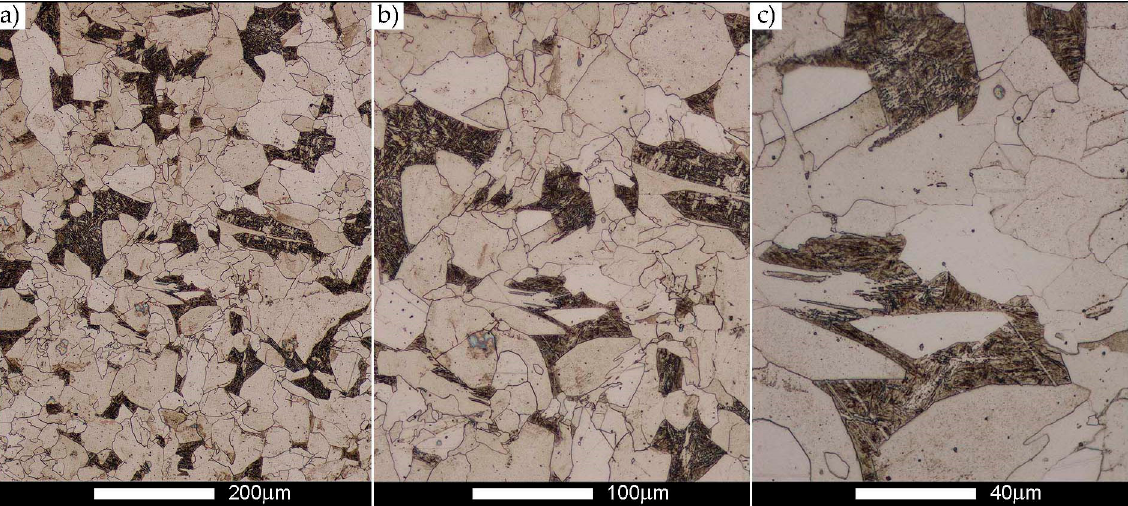
Figure 41. Welded joint microstructure of Hardox 450 steel with visible prior austenite grain boundaries, austenitised at 1200 ◦ C—WM2 zone shown in Figure 2. ( a ) 100 × ; ( b ) 200 × ; ( c ) 500 × .